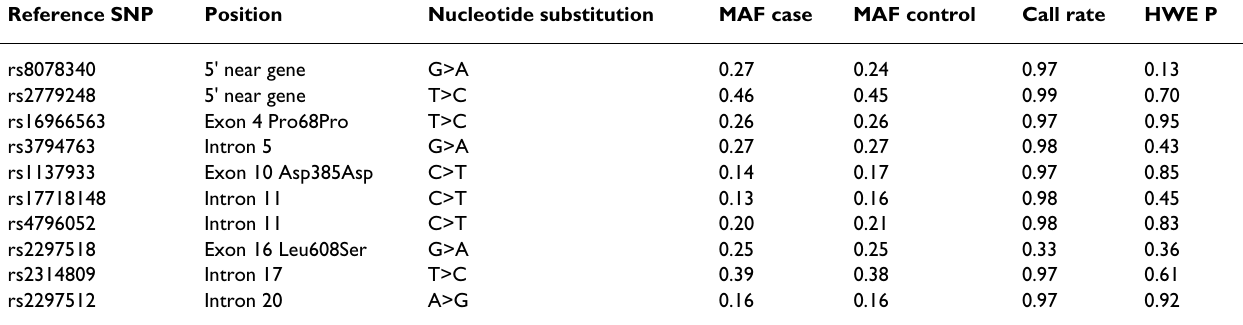
Table 1: NOS2A htSNP gene position, minor allele frequencies (MAF), successful genotype call rates and Hardy-Weinberg equilibrium p-values (HWE P) in Malawi IPD cases and controls Reference